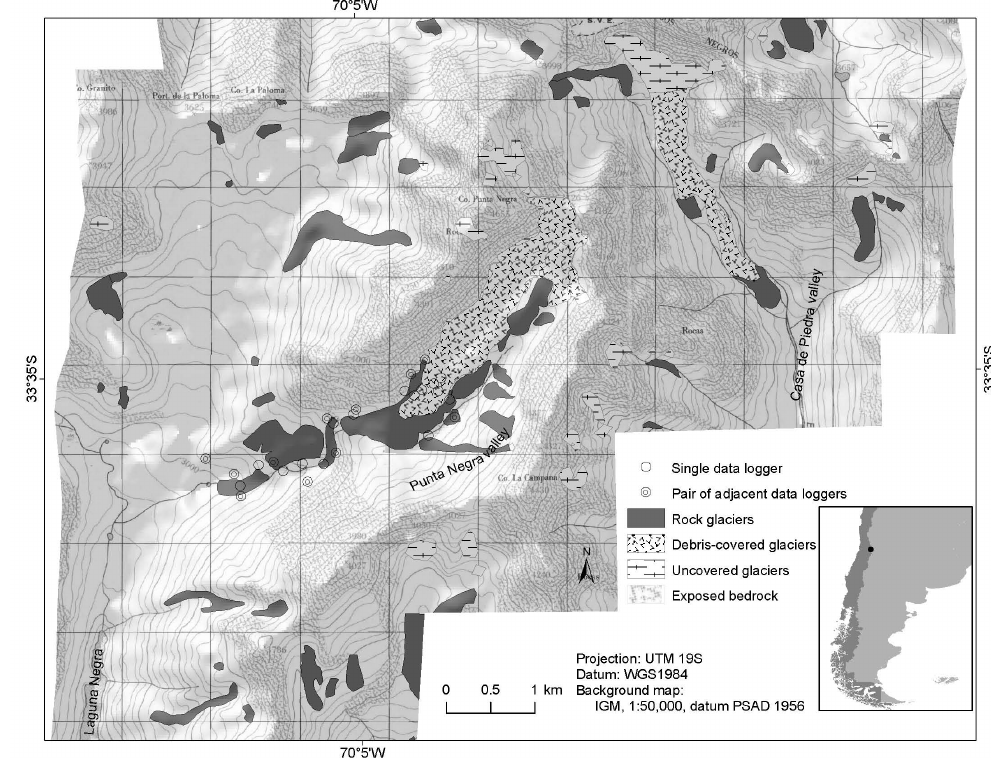
Fig. 1. Study area with ice-debris landforms and data logger